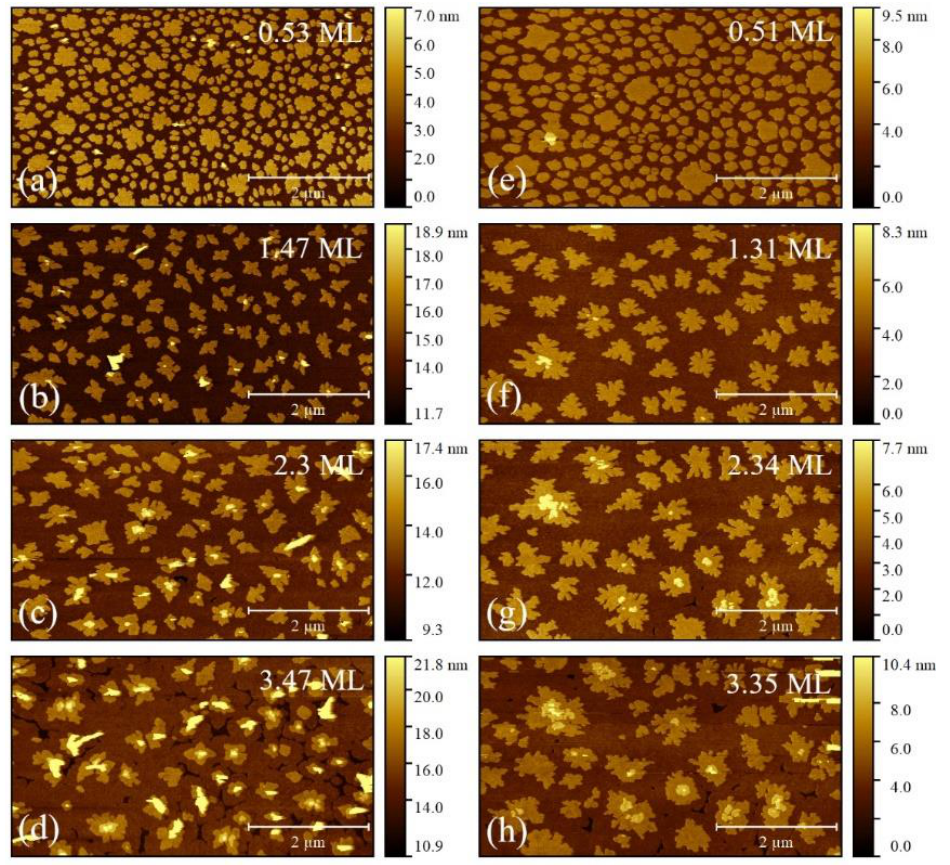
Figure 3. AFM images of 6T islands grown with OMBD in UHV on native silicon oxide at 25 °C ( a – d ) and at 50 °C ( e – h ). The surface coverage Θ for each AFM image is reported in the top-right corner. At each image, the same region was scanned, and the morphological evolution of OTFs can be followed along with the increasing coverage, up to the 4th ML. For graphical purposes, AFM images are cropped to 6.0 × 3.3 μm 2 , whereas some images ( b – d ) present a z -scale range starting from a height ≠ 0 nm because the underlying MLs are incomplete.